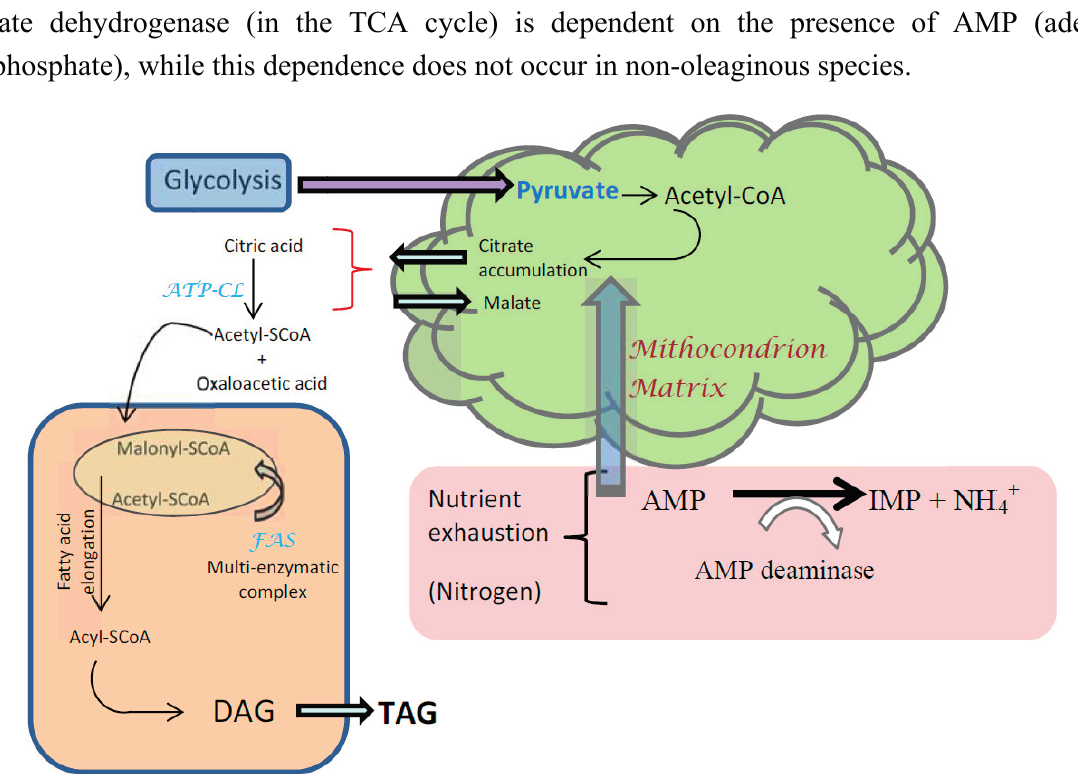
Figure 1. Schematic steps leading to de novo lipid biosynthesis and formation of TAG via the α -glycerol phosphate acylation pathway (adapted from [44,45]. IMP: Inosine monophosphate; DAG: Diacylglycerol; TAG: